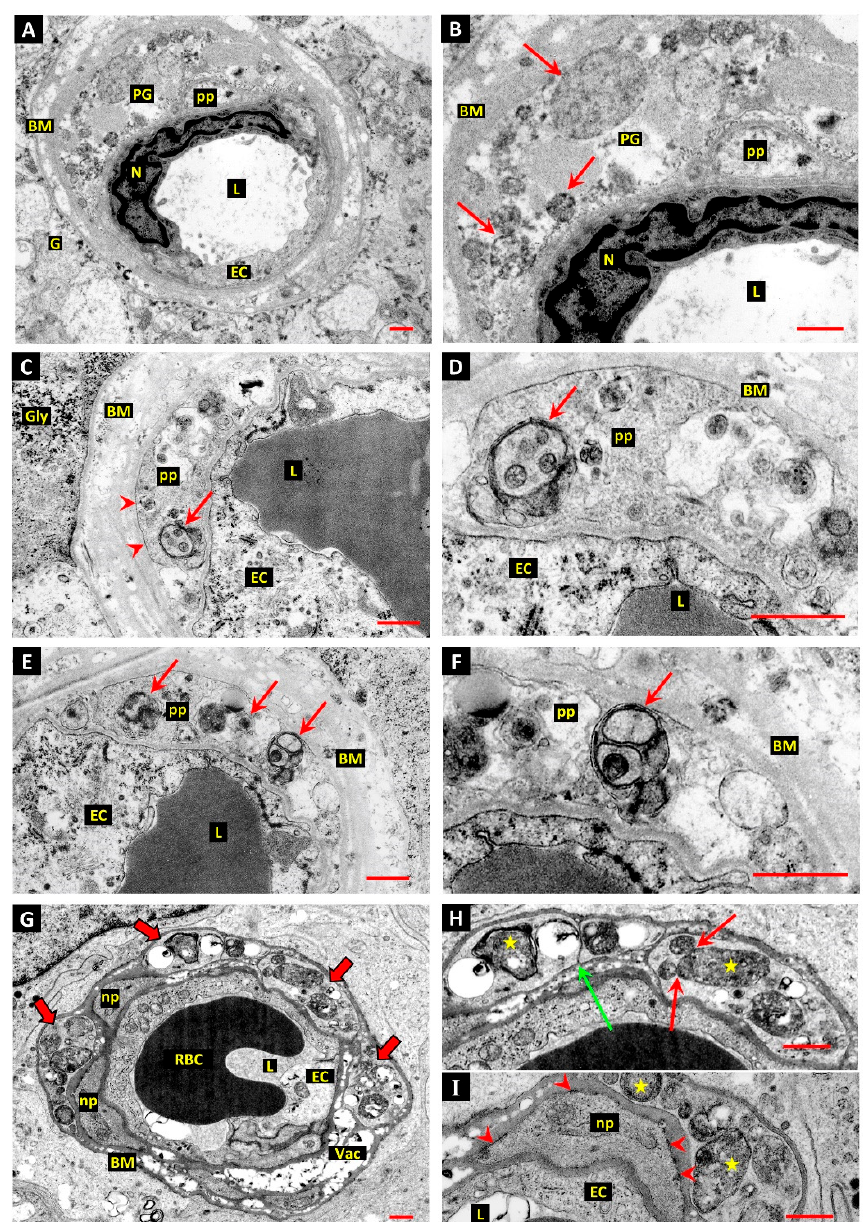
Figure 3. Evidence of autophagy associated with death of retinal pericytes in diabetic humans. ( A , B ): Electron micrographs of diabetic human donor retina shows a capillary blood vessel with an intact endothelial cell (EC) but no viable pericyte covering; endothelial cell nucleus (N), vessel lumen (L), glial cell (G). The basement membrane (BM) is grossly thickened and laminated, and a pericyte “ghost” (PG) filled with vesicular and granular material is present within the BM. The plasma membrane appears to have disintegrated, apart from that surrounding a small pericyte process (pp). Bar 1.0 µm. ( C – F ): Retinal capillary from diabetic human donor shows pericyte processes (pp) with intact plasma membranes (arrow heads in panel C) containing autophagosomes. The autophagosomes contain enclosed cytoplasm and organelles (arrows). Panels E and F feature another profile of the pericyte depicted in panels C and D, with more autophagosomes containing sequestered cytoplasm and organelles (arrows). The well-preserved autophagosomes depicted in panels D and F are thought to represent early stages in the development of the compartments. Bars 1.0 µm. ( G – I ): Capillary-sized retinal vessel from a human donor diagnosed diabetic within 1 year of enucleation shows several mural cell processes filled with autophagosomes (panel G—thick arrows). Panel G: Red blood cell (RBC); basement membrane vacuolisation (Vac). The plasma membranes are intact and double membranes can be defined around several of the autophagic bodies (stars in panels H